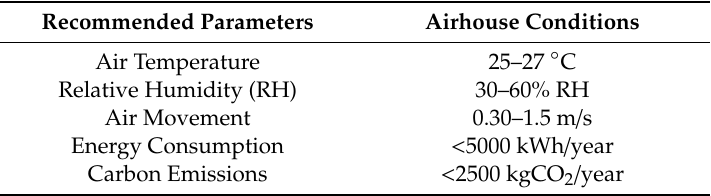
Table 1. Design conditions of the ‘airhouse’ standard (2012) for naturally ventilated